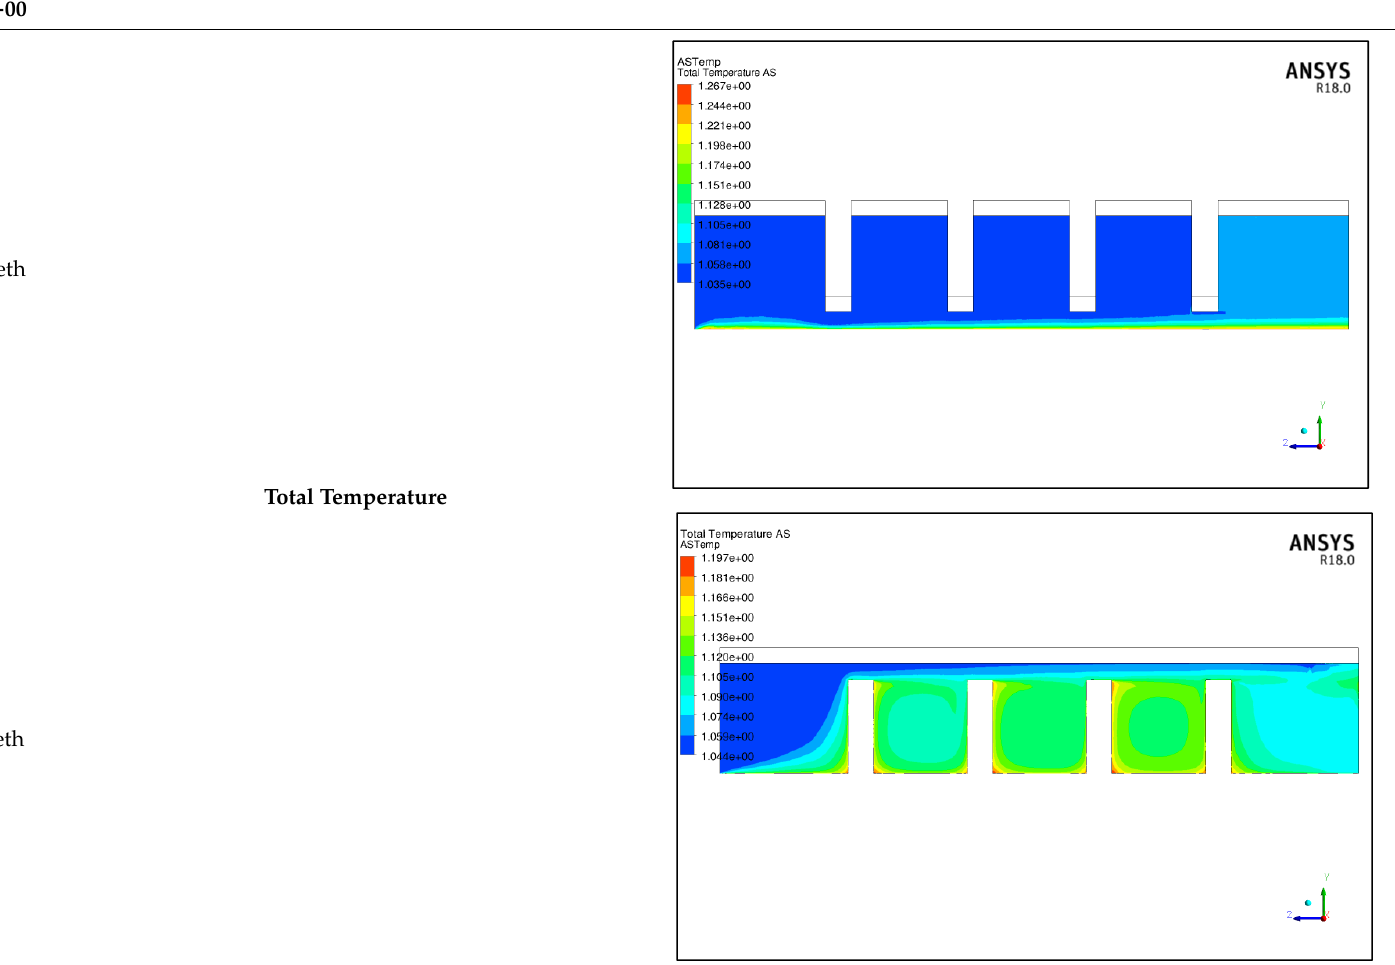
Table A2. Static pressure